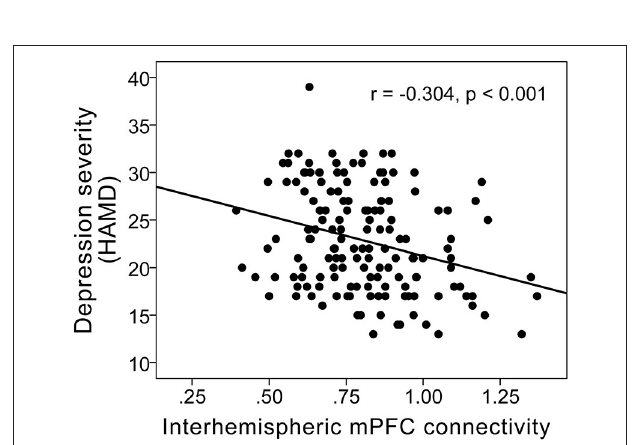
FIGURE 4 | Scatterplots showing a negative correlation between FC of the bilateral medial prefrontal cortex and depression severity (r = − 0.304; P < 0.001) in MDD